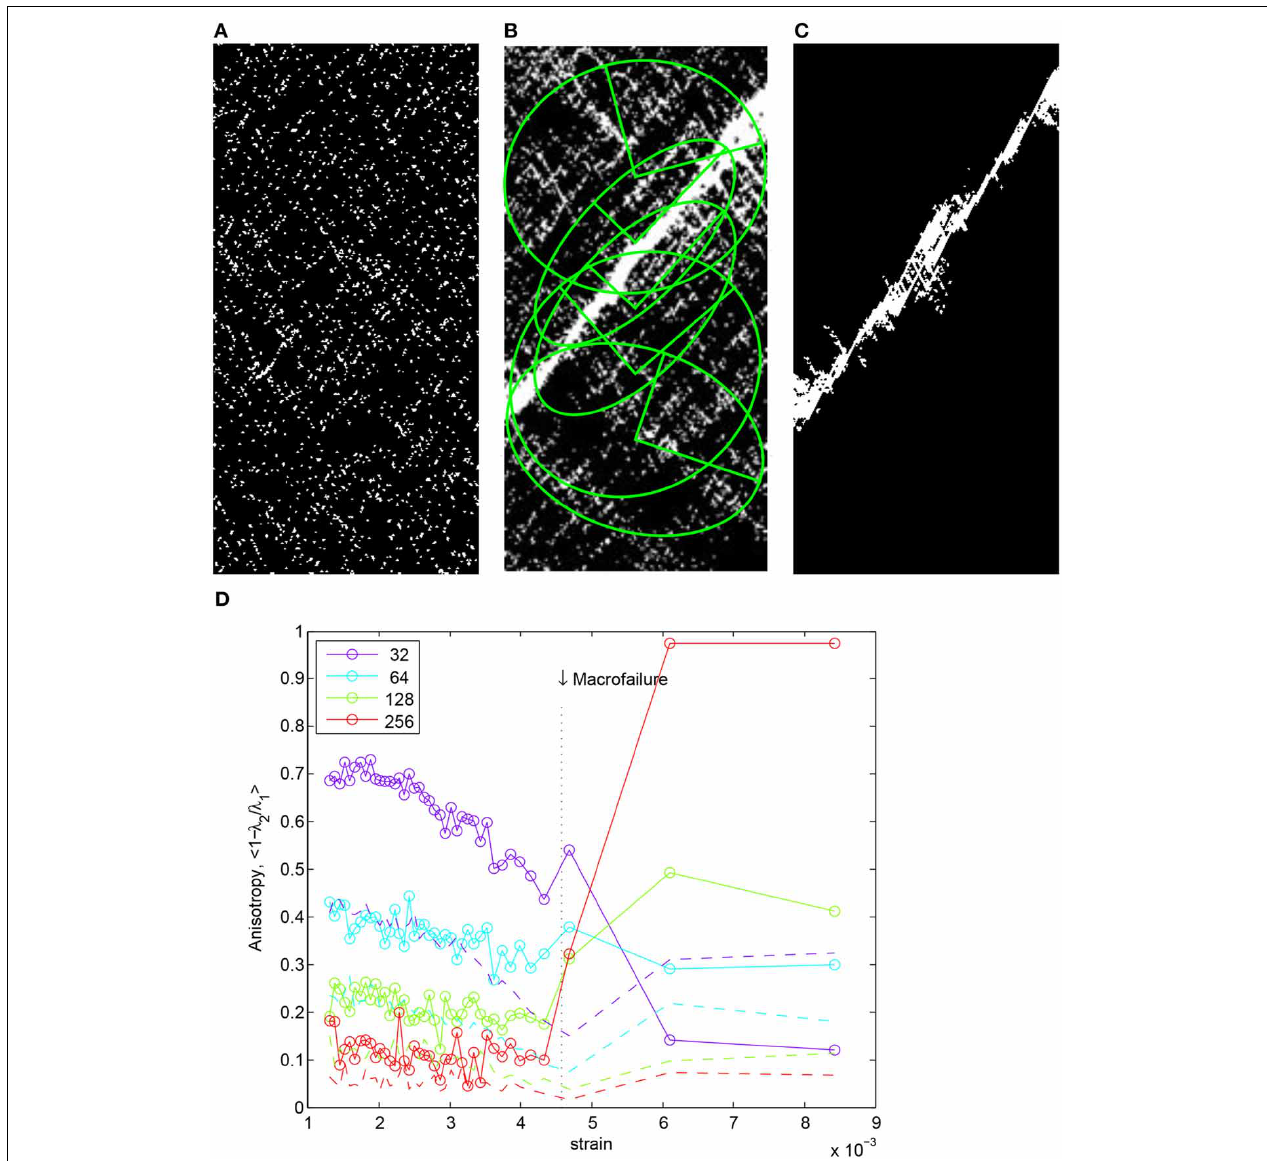
FIGURE 6 | Simulations of progressive damage in granite compression. (A–C) Snapshots of the incremental damage. The cells that experienced damage during the step appear in white and the others in black. The whole simulation is decomposed in 40 steps of incremental damage, each step corresponding to an equal number of damage events. (A) Step 34, (B) step